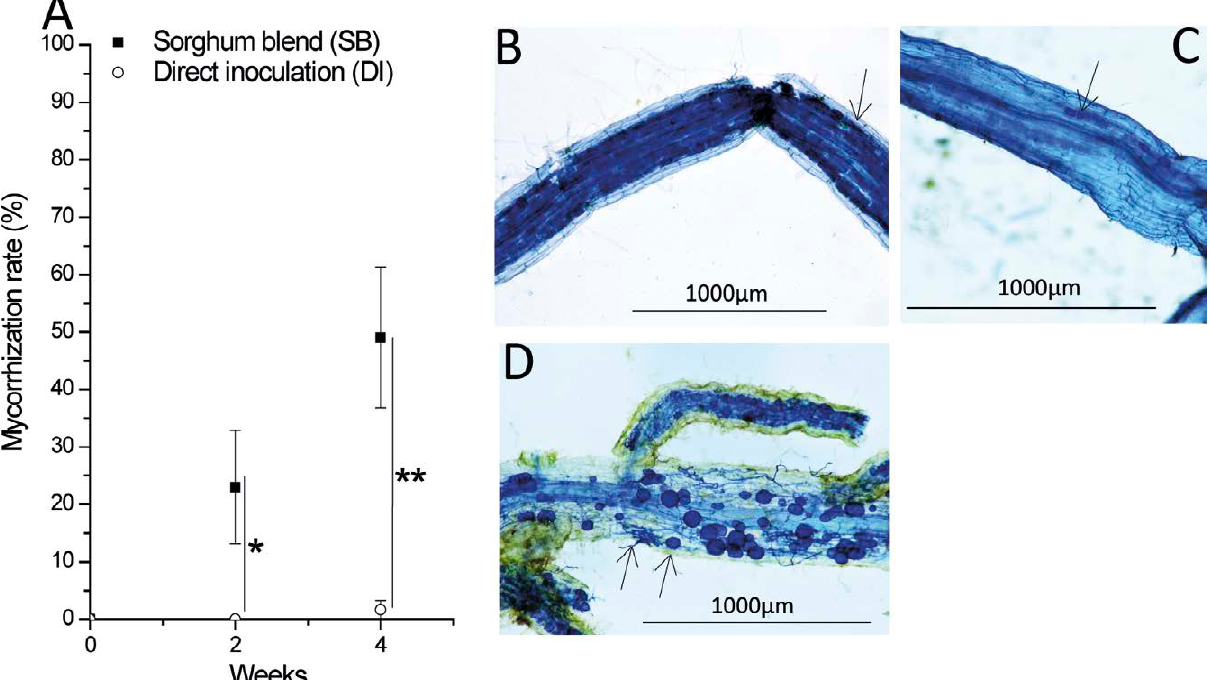
Figure 1. (Graph A) Mean mycorrhization rates (and standard errors: n ≥ 4) in tomato roots resulting from different AMF inoculation procedures at 2 and 4 weeks after inoculation. Before the tomato seedlings were transplanted to pots, a commercial inoculum was applied directly to their roots (direct inoculation: DI), or the soil was blended with leaves and roots of 6-week-old mycorrhized sorghum plants (micrograph D) (sorghum blend: SB). * and **, respectively, indicate differences at P < 0.05 and 0.01. Characteristic AMF colonisation of tomato roots grown for 4 weeks after SB (micrograph B) or DI (micrograph C) treatments. Arrows indicate typical AMF